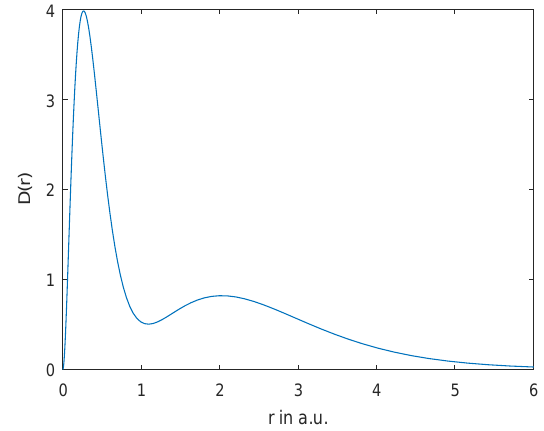
Figure 3. Radial density function D ( r ) for 1 s 2 2 s 2 1 S 0 in Be